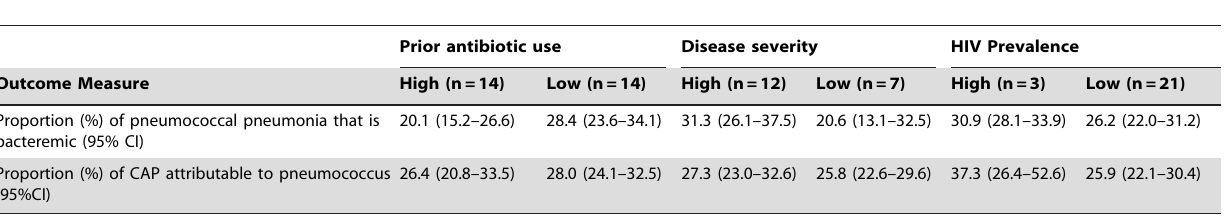
Table 2. Meta-analysis of the proportion of pneumococcal pneumonia that is bacteremic and the proportion of CAP attributable to pneumococcus, stratified by severity of disease, prior antibiotic use, and HIV status.